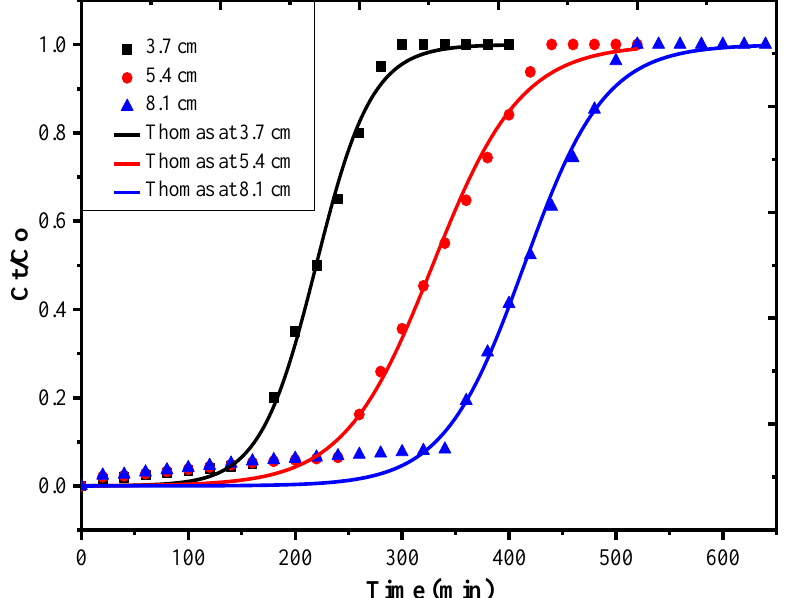
Figure 9. Break curves associated with Thomas model nonlinear fitting at 3.7 cm (black line), 5.4 cm (red line) and 8.1 cm (blue line) bed heights for CV adsorption on AS-g-PAni@MS nanocomposite.